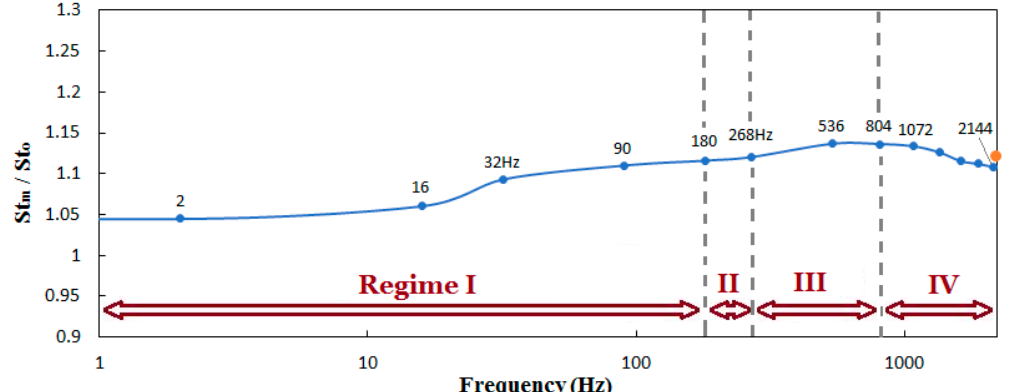
Figure 13. The variation of the spanwise-averaged Stanton number ratio in terms of frequency (Hz) at X/D = 7 for M = 0.5 obtained by the FLUENT, DES, Realizable k- epsilon model. The orange color point is the result for the multi-frequency unsteady flow. It represents the spanwise-averaged Stanton number ratio when Equations (28) and (29) are used instead of individual frequencies.